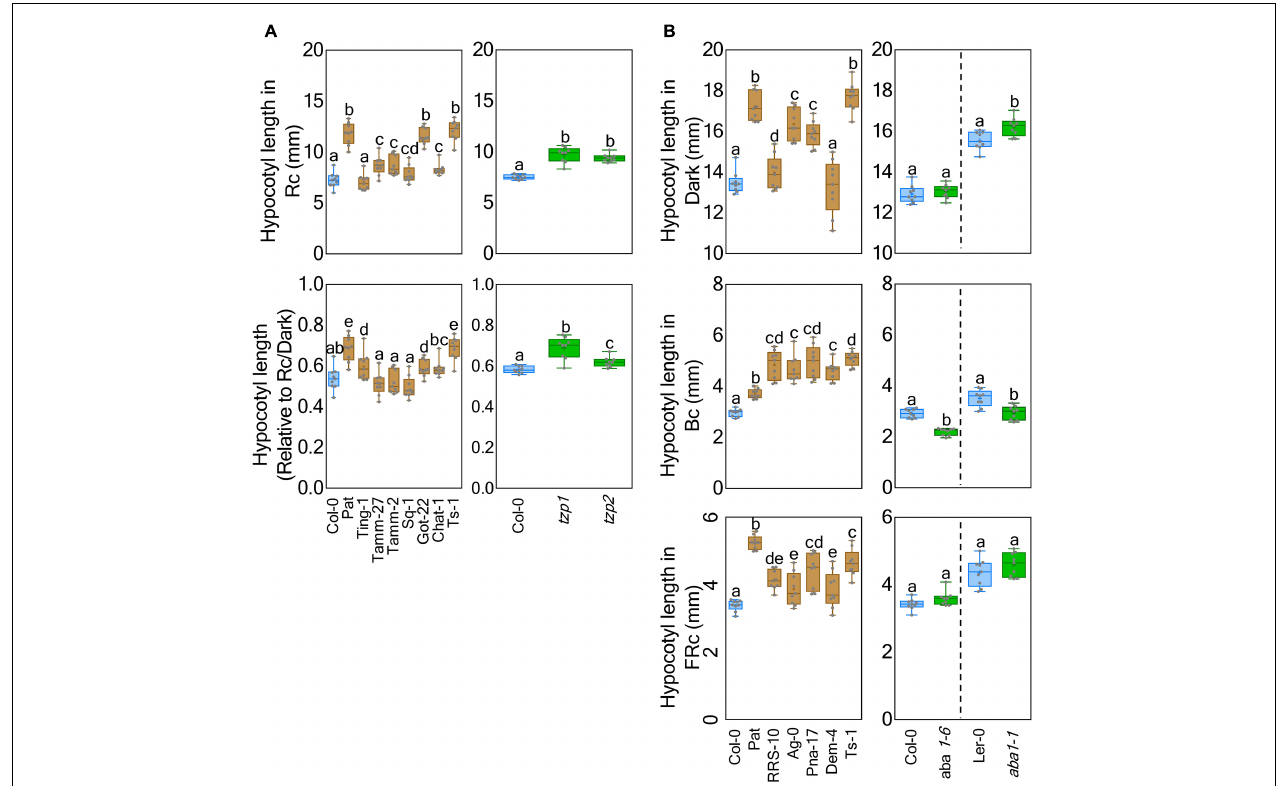
FIGURE 5 | TZP1 and ABA1 as candidate genes for Rc1 and Bc1 QTLs, respectively. (A) Seedling hypocotyl length was measured under Rc and Rc/dark conditions for accessions Ting-1 (CS76612), Tamm-2 (CS76610), Tamm-27 (CS77341), Sq-1 (CS77266), Got-22 (CS76884), Chat-1 (CS76463), and Ts-1 (CS76615) that shared some or all TZP- Pat polymorphisms; and in parallel tzp-1 and tzp-2 with corresponding Col-0 as a control. (B) Seedling hypocotyl length was measured under dark, Bc, and FRc conditions for accessions RRS-10 (CS76592), Ag-0 (CS76430), Pna-17 (CS76575), Dem-4 (CS76794), and Ts-1 (CS76615) that shared all ABA1 -Pat polymorphisms; and in parallel aba1-1 and aba1-6 with the corresponding Ler and Col-0 controls, respectively. Box and whisker diagrams depict data around the median, while distinct letters indicate significant differences between means analyzed by LSD test ( p -value <